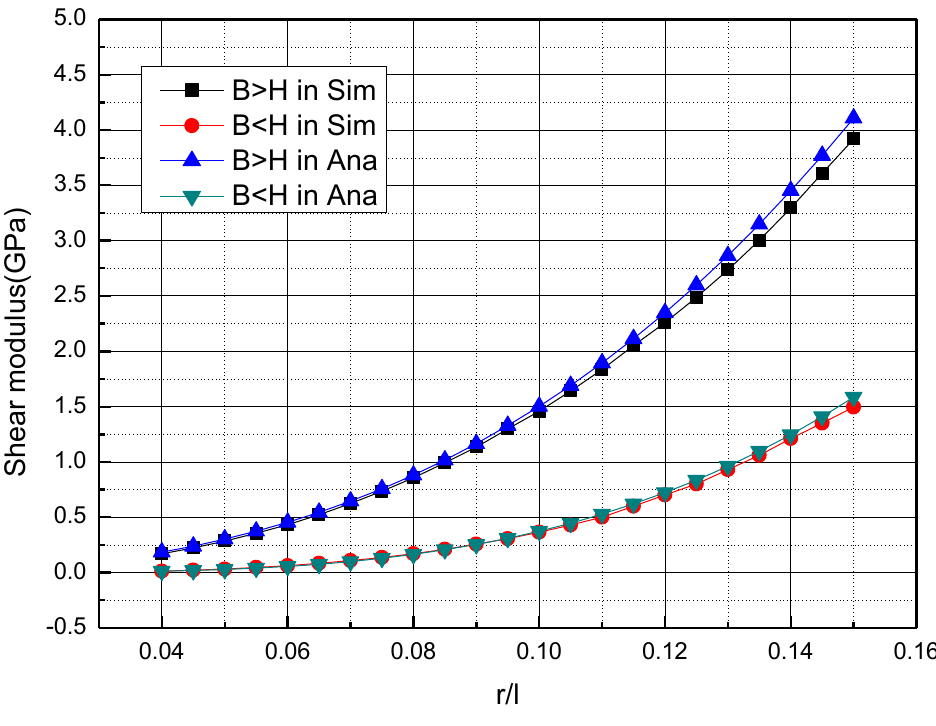
Figure 16. The curve of the shear modulus versus the slenderness ratio (r/l) of cubic sandwich BCC